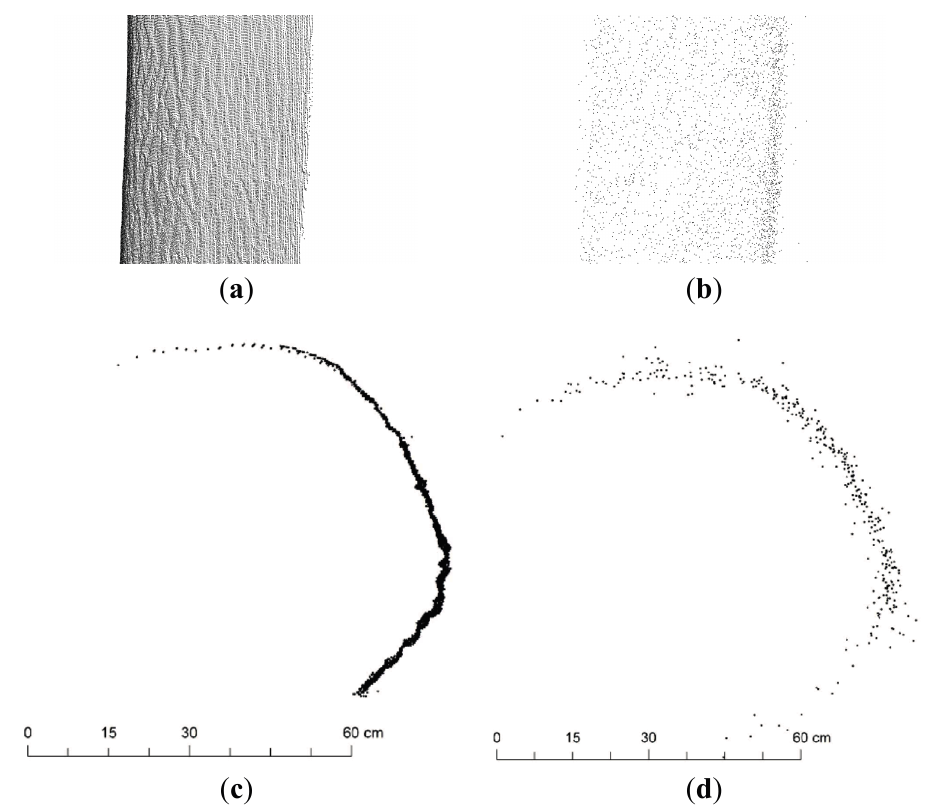
Figure 7. Point cloud stem comparisons for ( a , b ) side view of FARO and ZEBl; ( c , d ) planar view—10 cm slice of FARO and